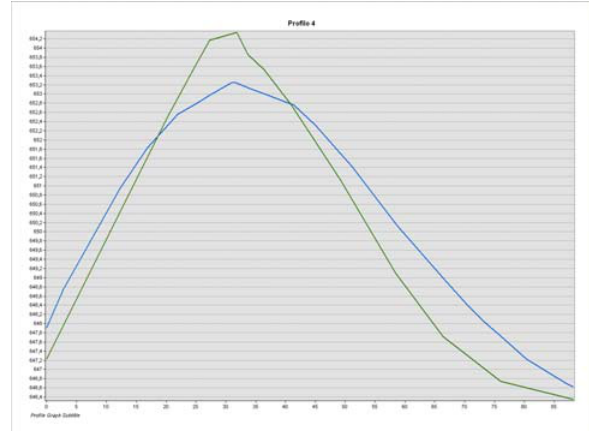
Figure 7. Comparison between profiles (test